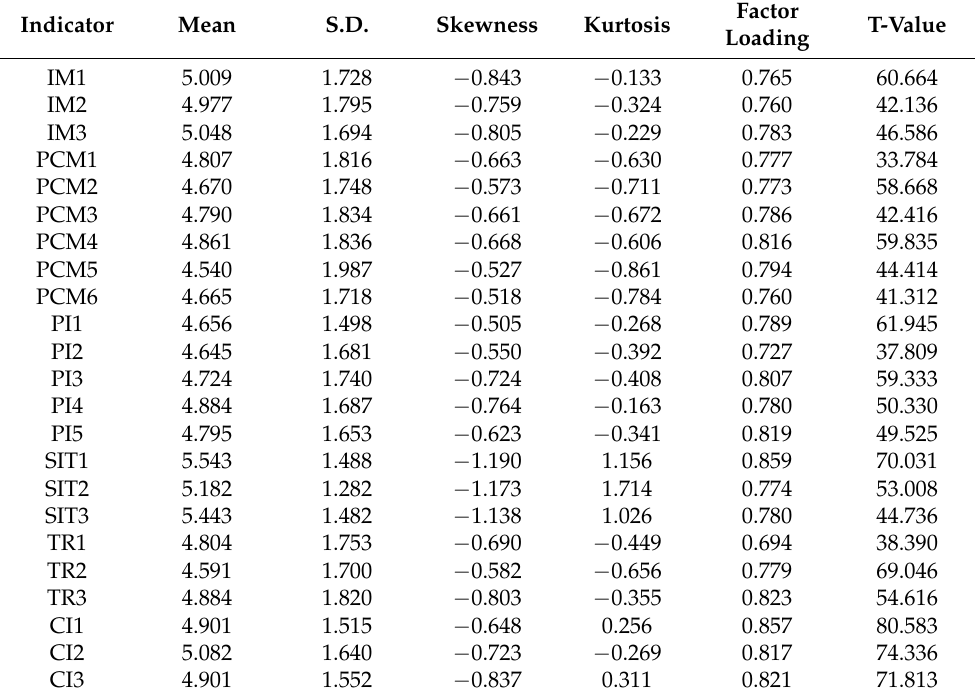
Table 2. Descriptive statistics and factor loadings for measurement items.